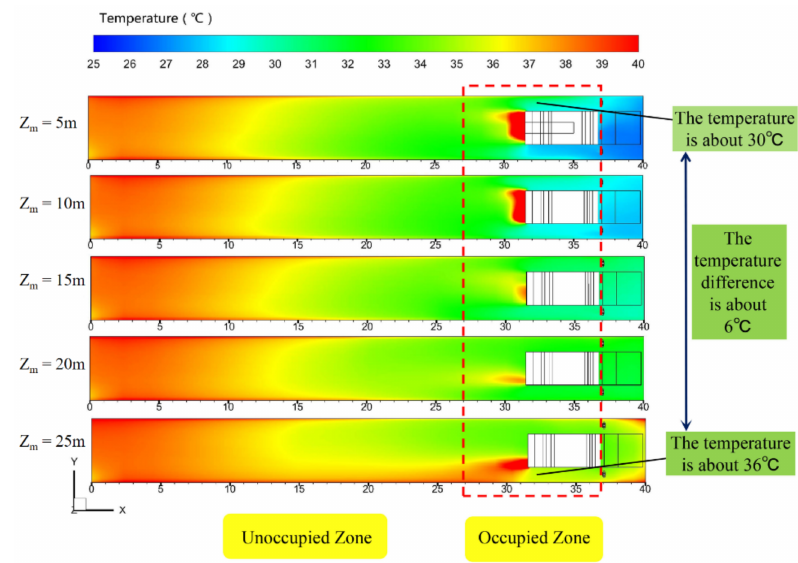
Figure 9. Dry bulb temperature distributions on Plane A for different Z m .